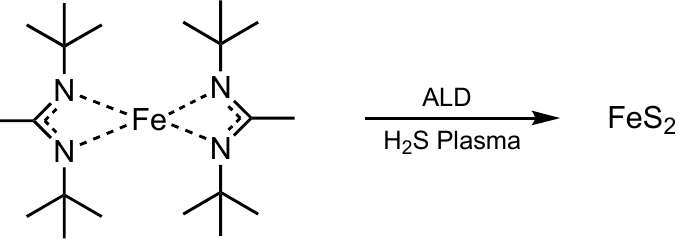
Figure 3. Pyrite FeS 2 thin-film production by Atomic Layer Deposition (ALD) [49] .